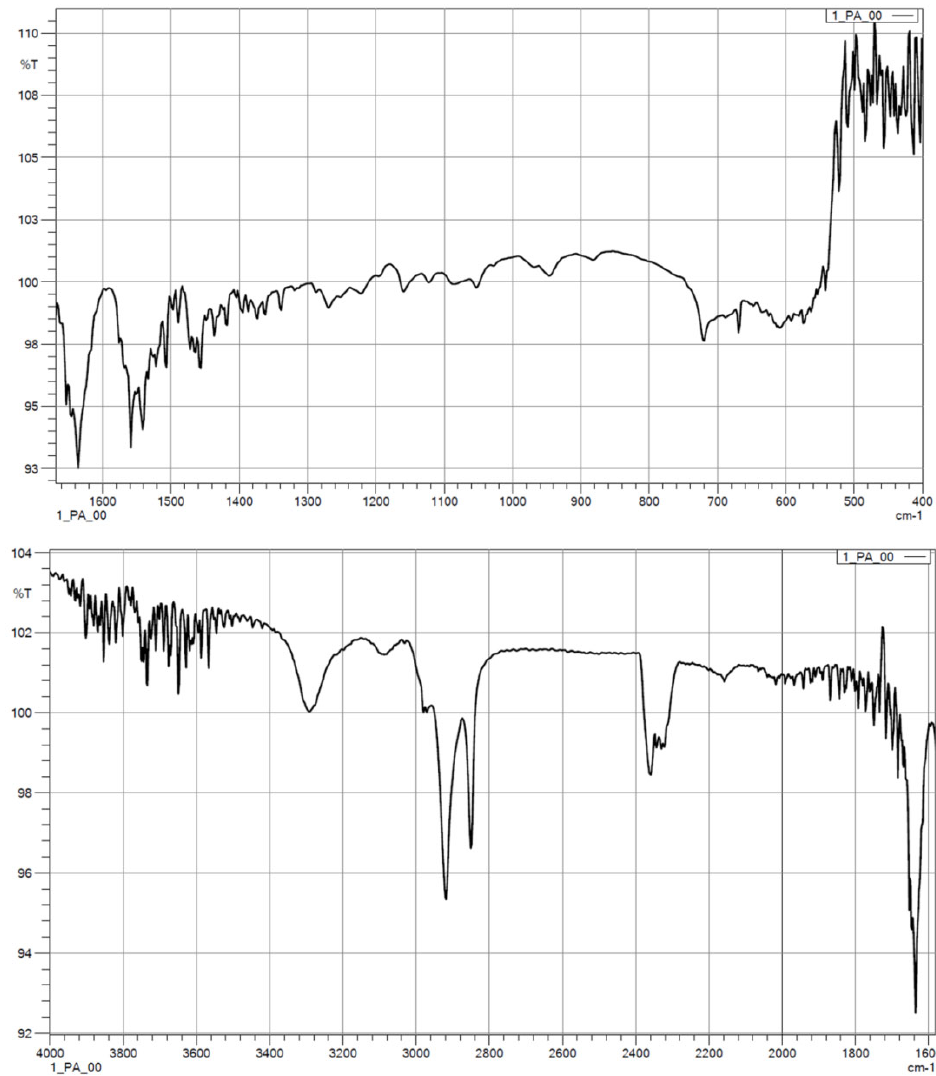
Figure 6. IR spectra for pure PA ‐ 12 before artificial ageing. Table 7. IR band description for PA ‐ 12 samples.